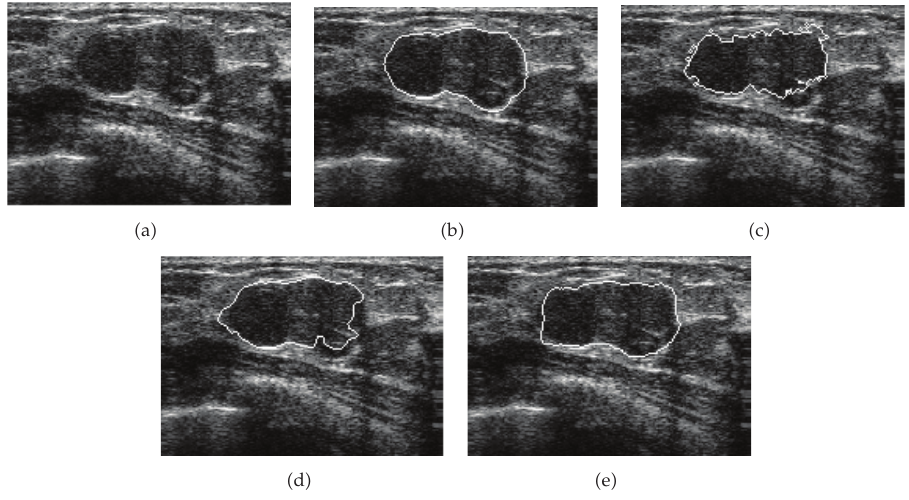
Figure 10: Segmentation of a benign breast tumor with low contrast and high speckle noise. (cid:3) a (cid:4) Original image. (cid:3) b (cid:4) Golden standard. Segmentation results of (cid:3) c (cid:4) GAC (cid:5) 11 (cid:6) , (cid:3) d (cid:4) DRLSE (cid:5) 16 (cid:6) , and (cid:3) e (cid:4) the proposed PGBLSE